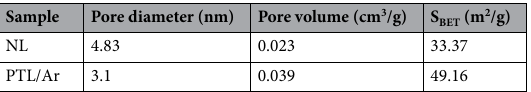
Table 2. Structural properties of NL and PTL/Ar.